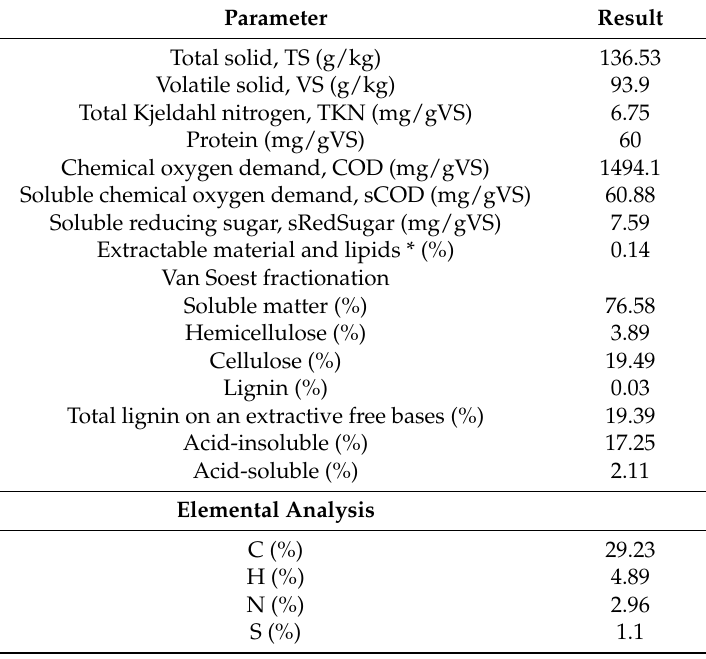
Table 1. Average characteristics of the greenhouse crop